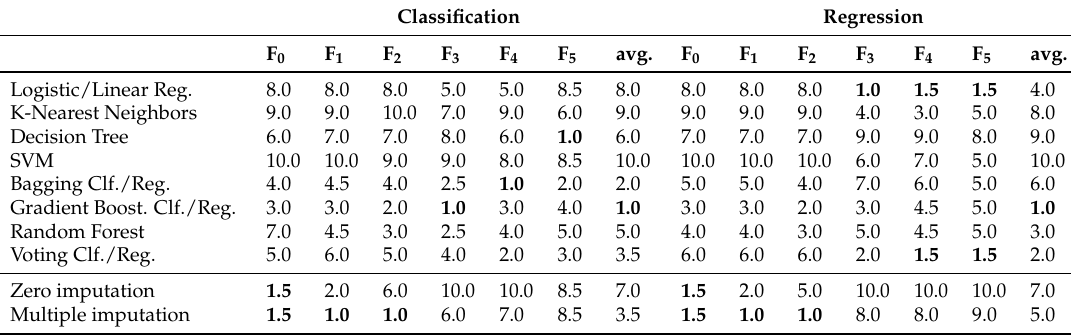
Table 6. Rankings of classification and regression models for different feature sets for sugar.